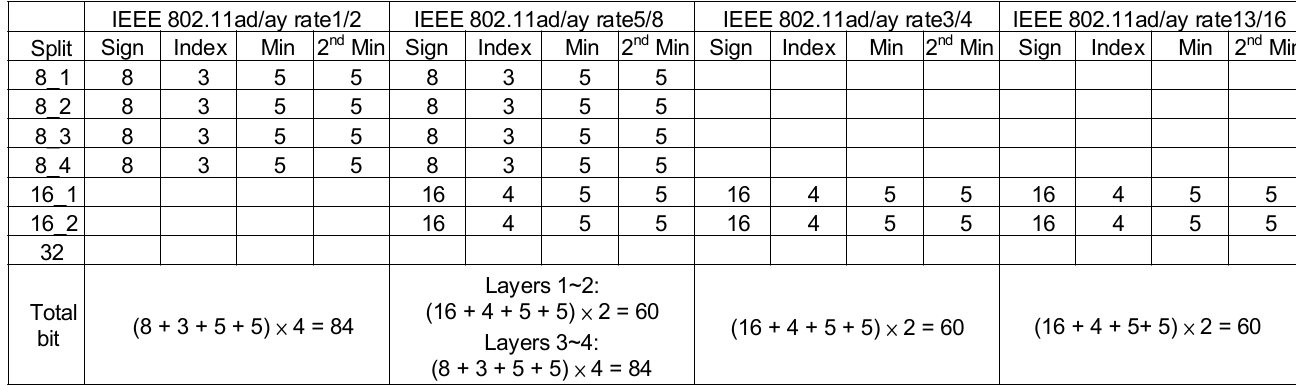
Figure 30. The number of bits required by the extrinsic memory in the IEEE 802.11ad/ay standard with different code rates.